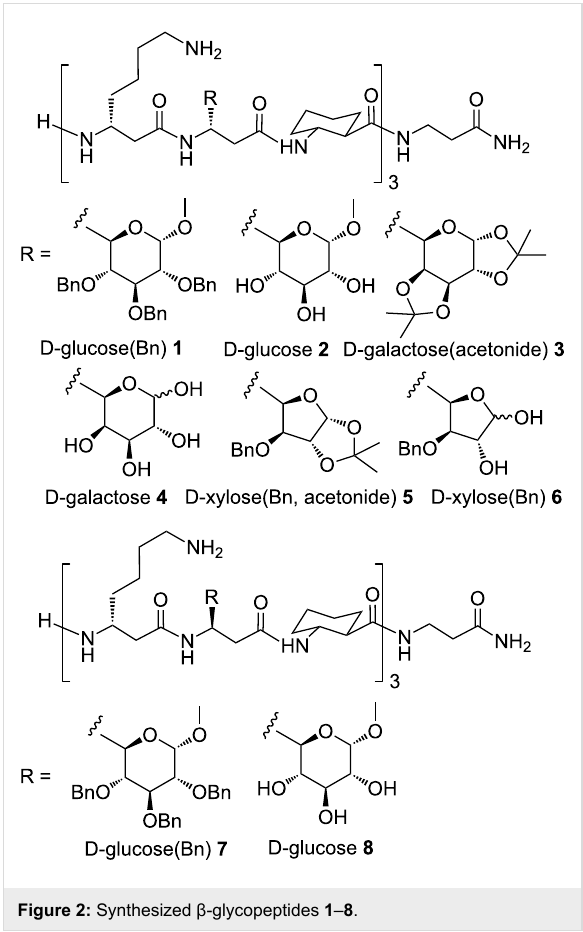
Figure 2: Synthesized β -glycopeptides 1 – 8